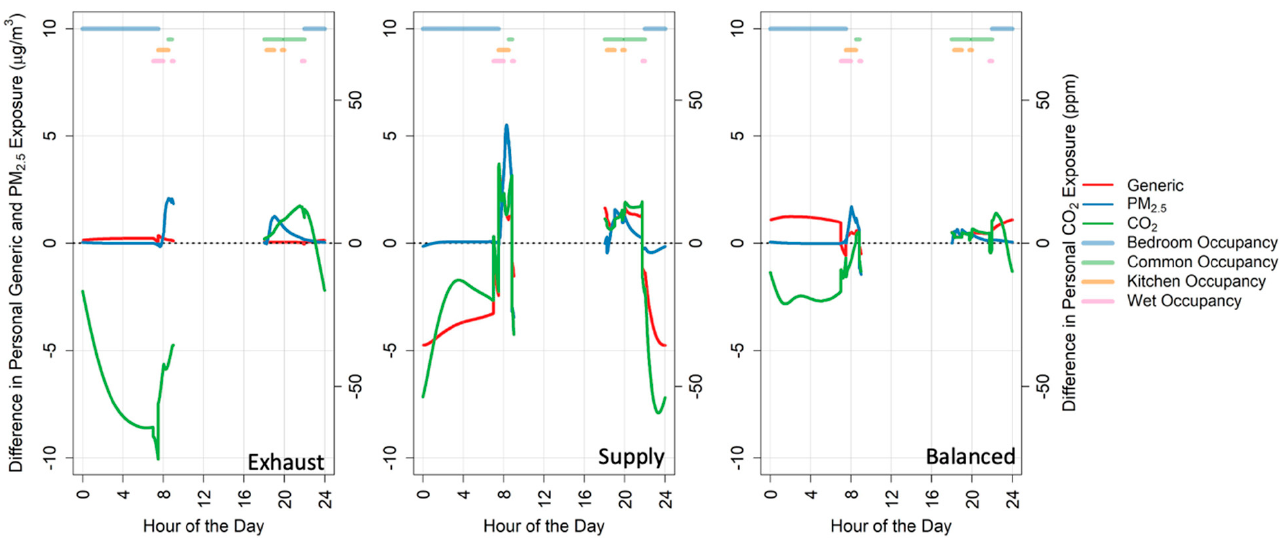
Figure 2. Comparison of baseline personal exposures for single– and multi–point configurations. Fan types include exhaust ( left ), supply ( middle ) and balanced ( right ) for a 24 h period for an individual occupant not in the dwelling from 9 a.m. to 5 p.m. and moving between zones.